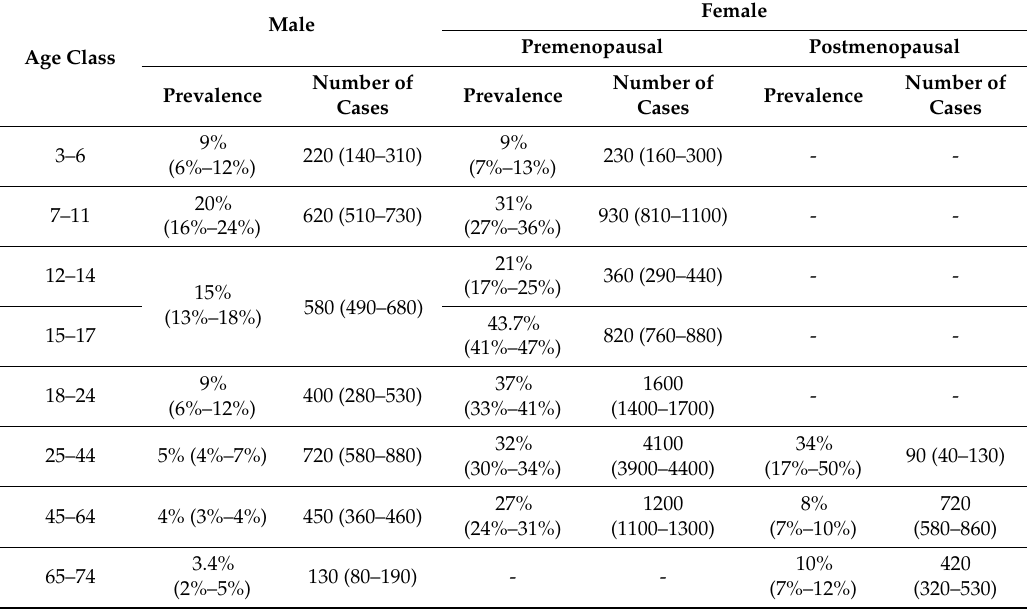
Table 3. Prevalence and number of iron deficiencies per 100,000 French individuals, per age class and gender. Mean value and its 95% confidence